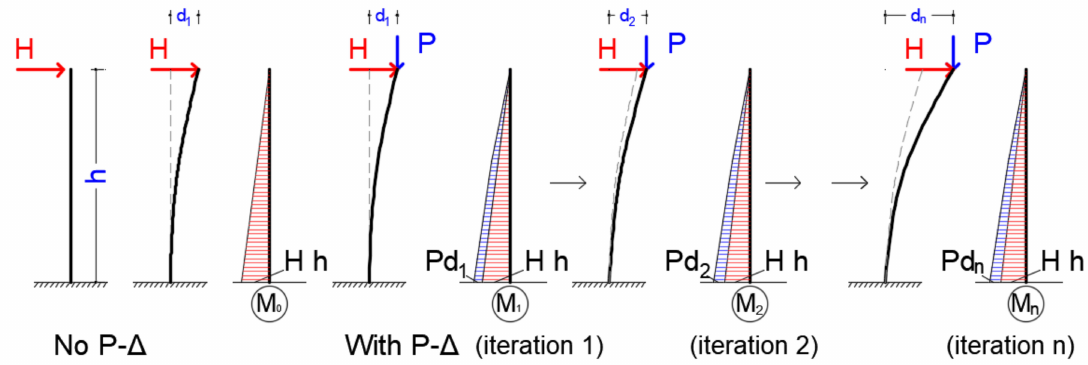
Figure 1. Forces acting on a column type element in the deformed